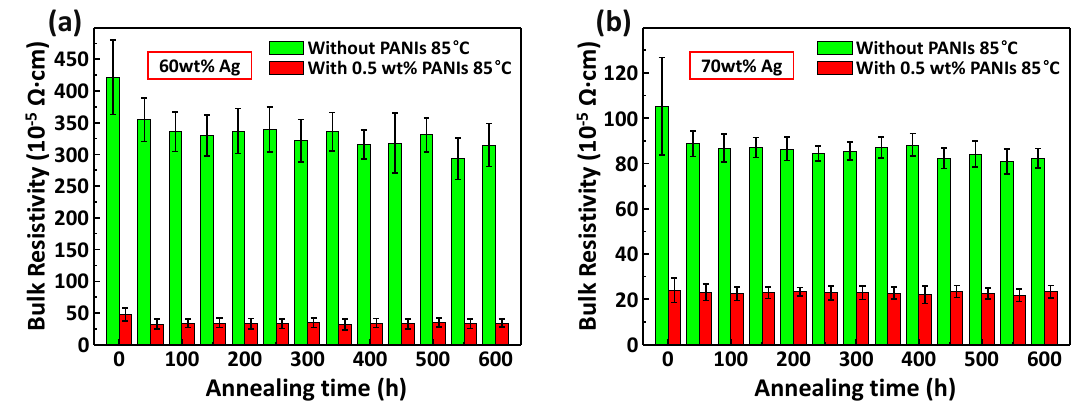
Figure 5. Bulk resistivity evolution of ( a ) 60 wt% and ( b ) 70 wt% silver-filled ECAs with or without 0.5 wt% PANIs during a 600-h aging test.